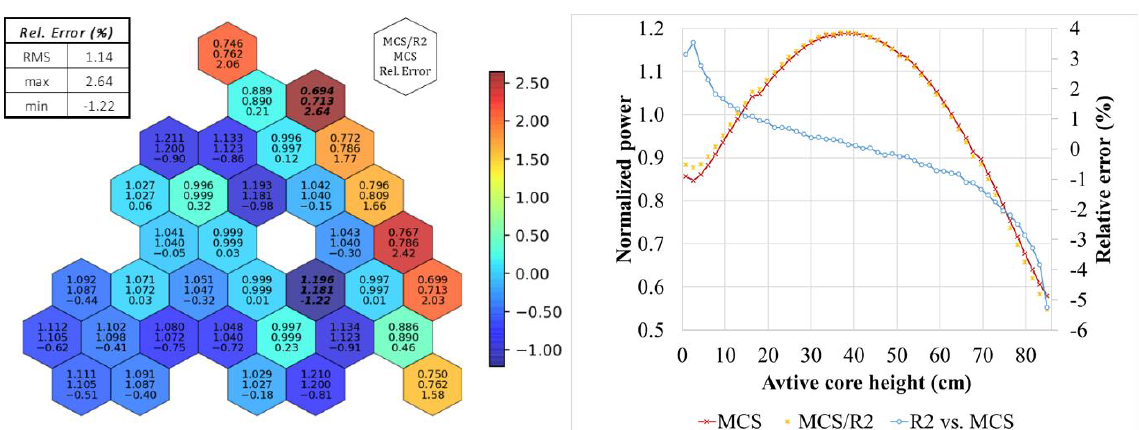
Figure 7. Normalized assembly radial and axial power distribution, MCS/R2 vs